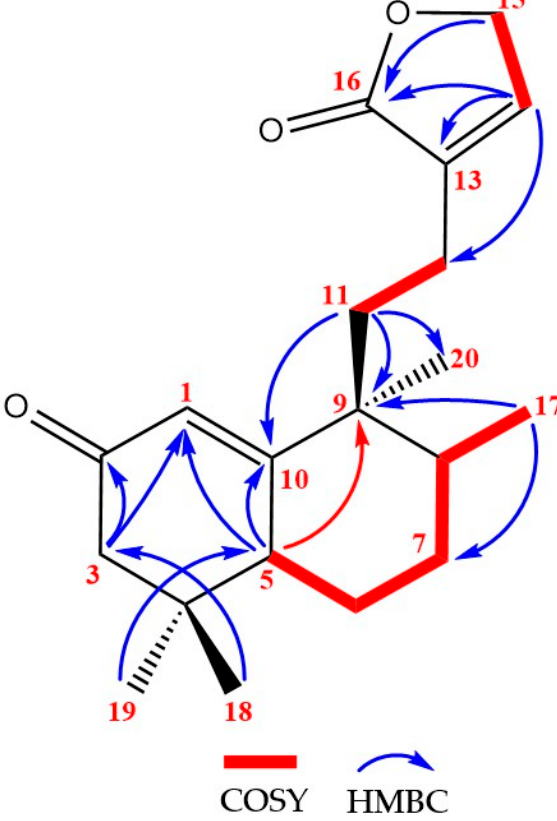
Figure 2. Key COSY and HMBC correlations of compound 1 . Table 2. Reference 13 C ‐ NMR chemical shifts of two known halimane diterpenoids with part of the scaffold of 1 .